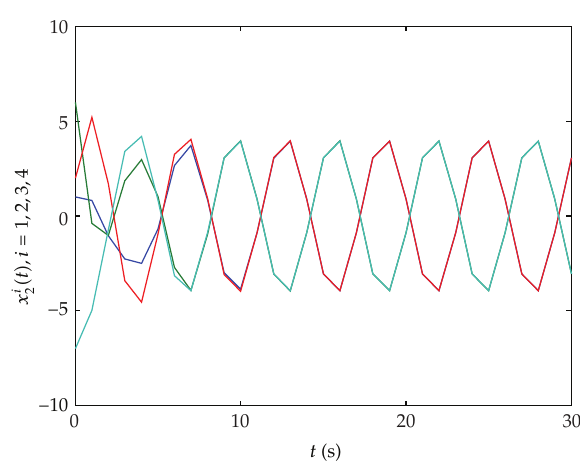
(cid:6) t (cid:7) , i (cid:9) 1 , 2 , 3 , 4 for G 2